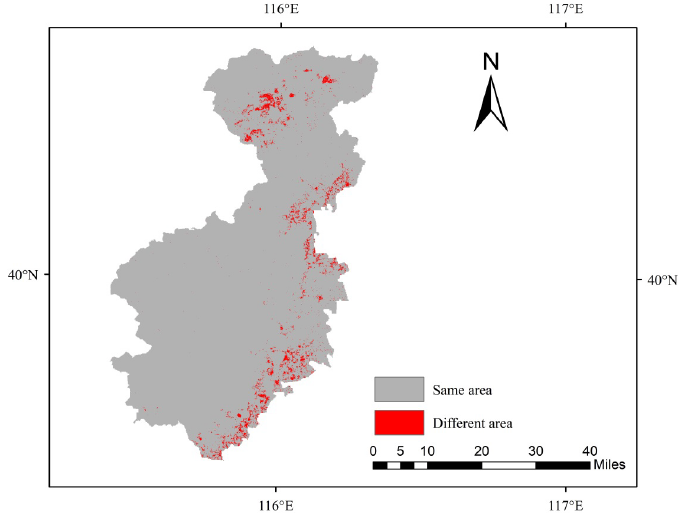
Figure 8. The areas of diversity between the two scenarios of natural development and the imple- mentation of regional planning of the ECA in western Beijing in 2030. mentation of regional planning of the ECA in western Beijing in